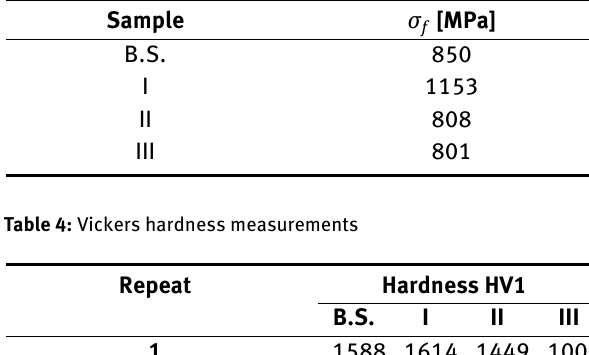
Figure 4: SEM microphotographs of samples: a) 10 h, b) 2.5 h, c) 5 h and d) blind sample. Table 3: Results of the 4PBT